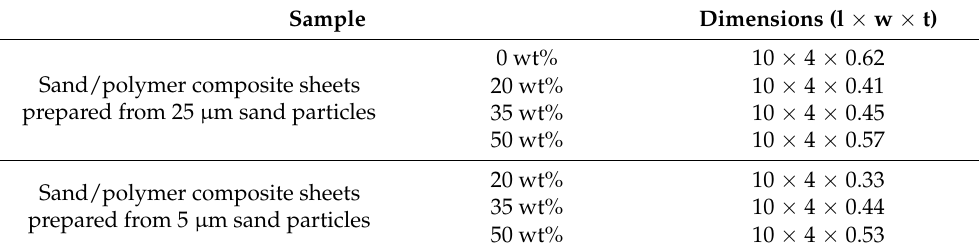
Table 4. Dimensions of prepared composite